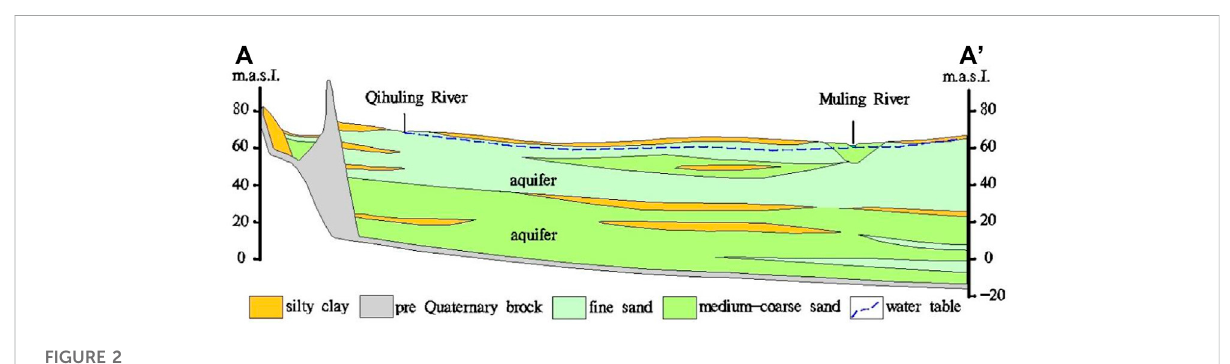
FIGURE 2 Hydrogeologic cross section A-A ′ shown in Figure